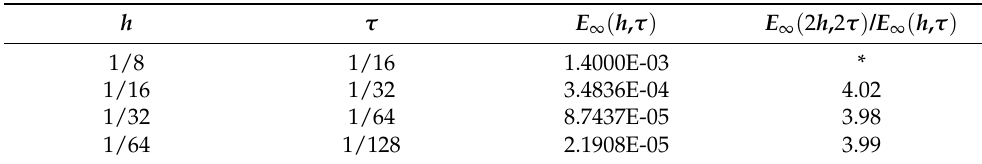
Table 4. The maximum error E ∞ ( h , τ ) corresponding to the asynchronous step length, where * means null.